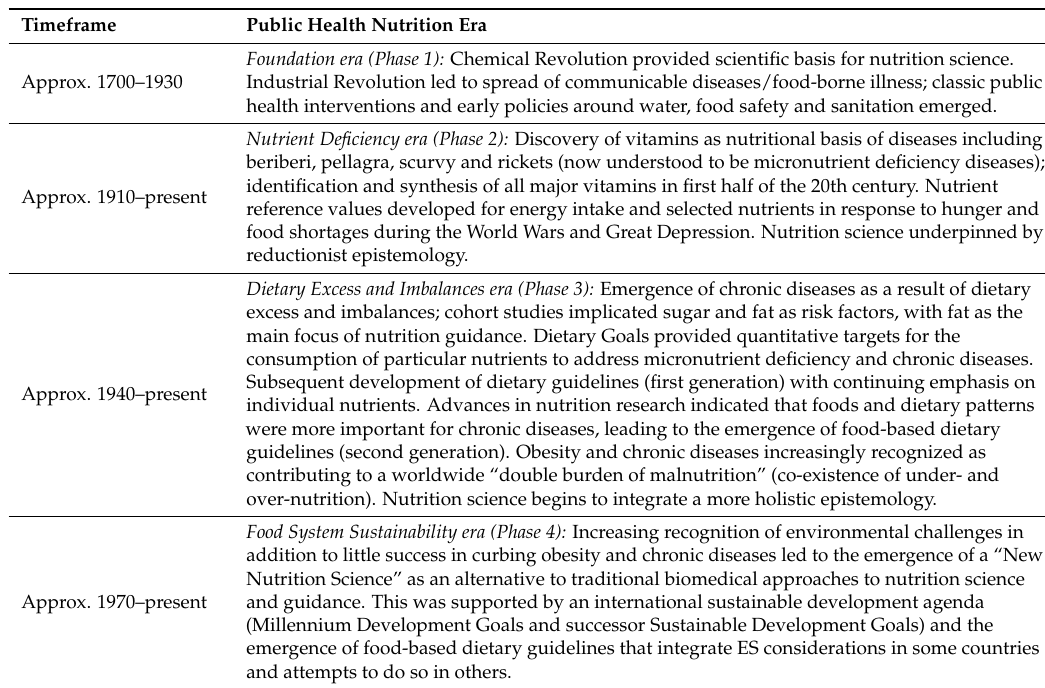
Table 2. Summary of the main public health nutrition